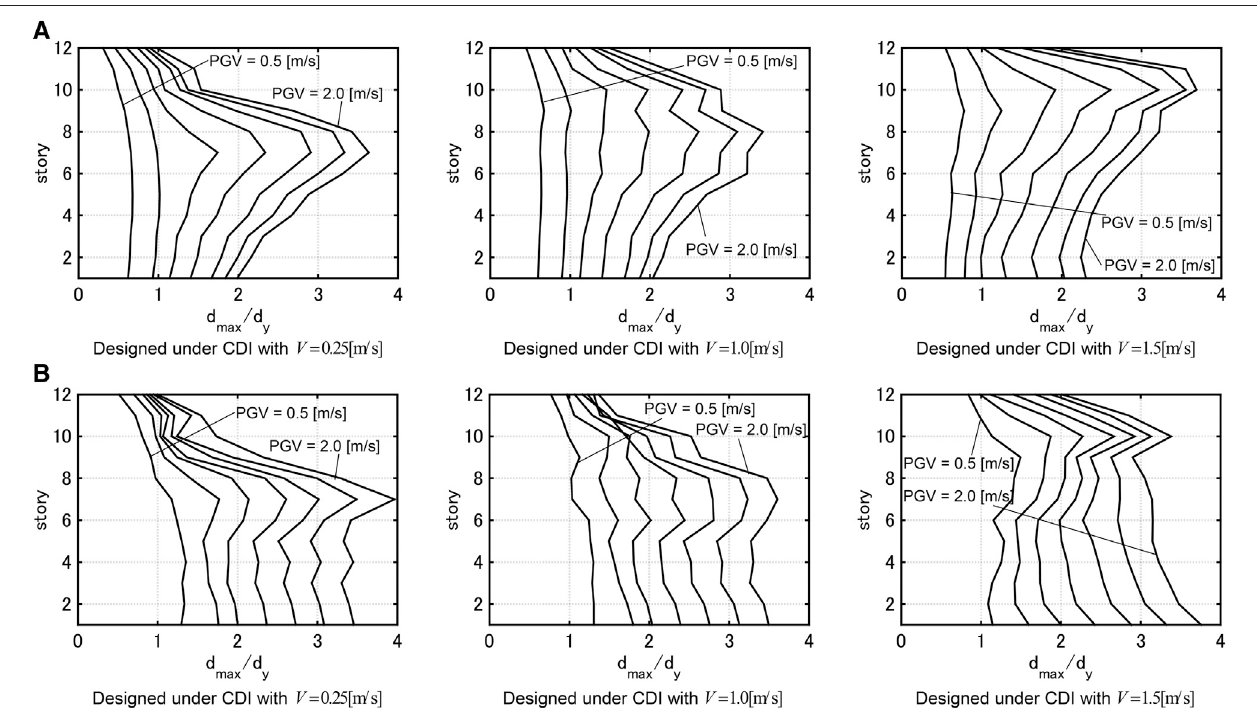
FIGURE8| Maximuminterstorydriftsforampli fi edrecordedgroundmotions, (A) RinaldistationFN(Northridge,1994), (B) KobeUnivNS(Hyogoken-Nanbu,1995) (Akehashi and Takewaki, 2020b).